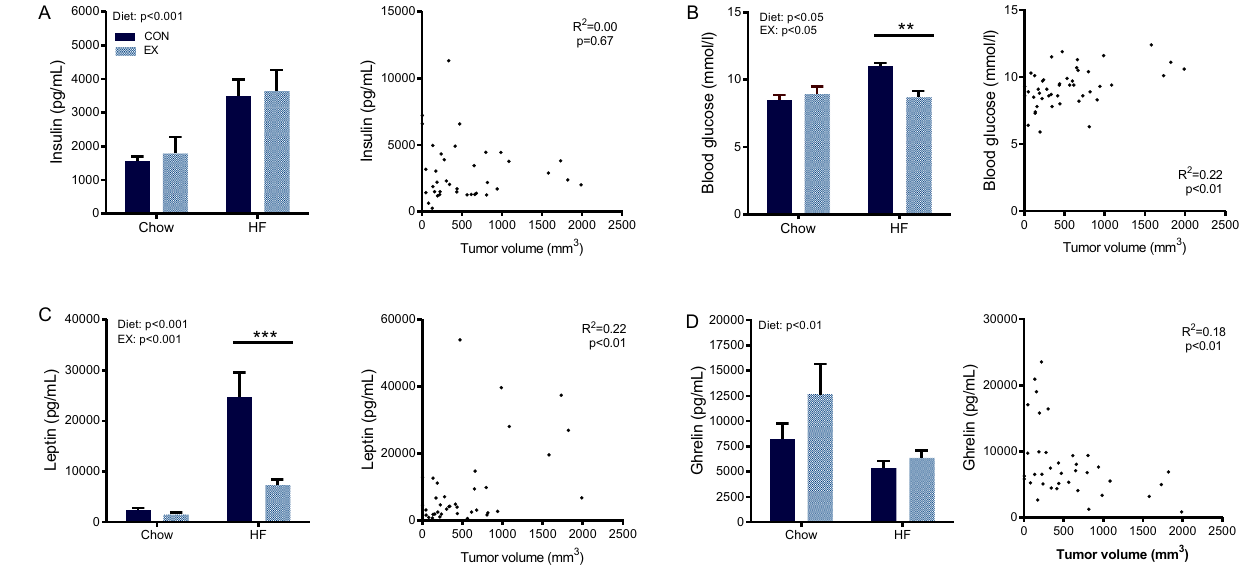
Figure 3. Tumor growth is correlated with systemic regulation of glucose, leptin and ghrelin. From mice in study design 1, serum concentrations and association to tumor volume of ( A ) insulin, ( B ) glucose, ( C ) leptin and ( D ) ghrelin were determined. Statistical significance was determined by 2-way ANOVA with Tukey’s post hoc test and linear regression analyses. P values for diet and EX describe the results of the 2-way ANOVA, while individual stars indicate difference from control (CON) group within each diet group. ** p < 0.01, *** p <